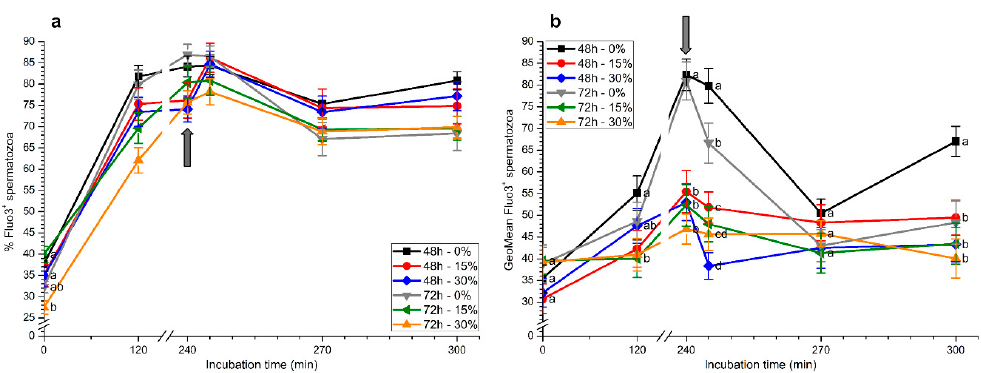
Figure 5. Percentages ( a ) and geometric mean intensity ( b ) of Fluo3 + spermatozoa during in vitro capacitation and progesterone-induced acrosomal exocytosis (300 min) after previous storage of spermatozoa at 17 °C with different concentrations of seminal plasma (0%, 15%, and 30%) for 48 h or 72 h. Grey arrow indicates the time at which 10 μ g/mL progesterone was added to induce acrosomal exocytosis (i.e., 240 min). Different letters mean significant ( p < 0.05) differences between treatments at a given time point. Data are shown as mean ± SEM for seven independent experiments.